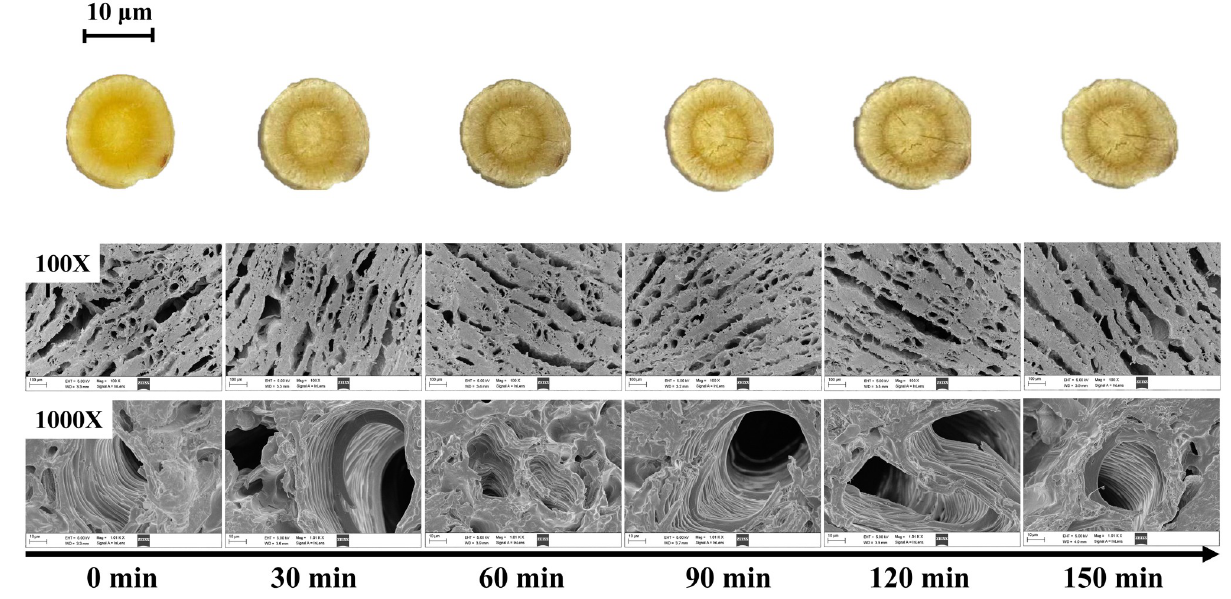
Fig 7. Scanning electron micrographs of 100X (first) and 1000X (second) for AR pieces at different drying times.